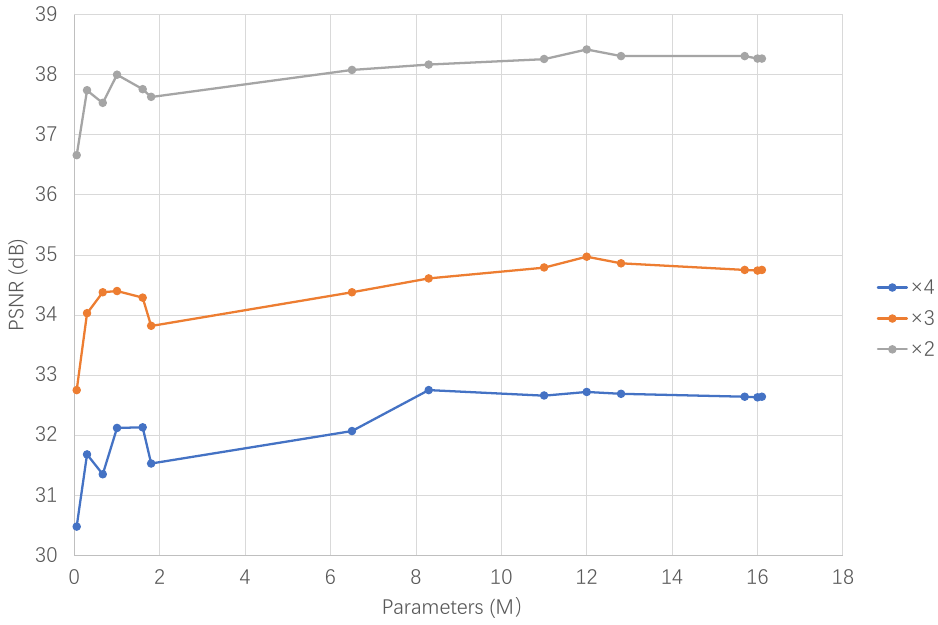
Figure 8. Variation of PSNR with the number of parameters.